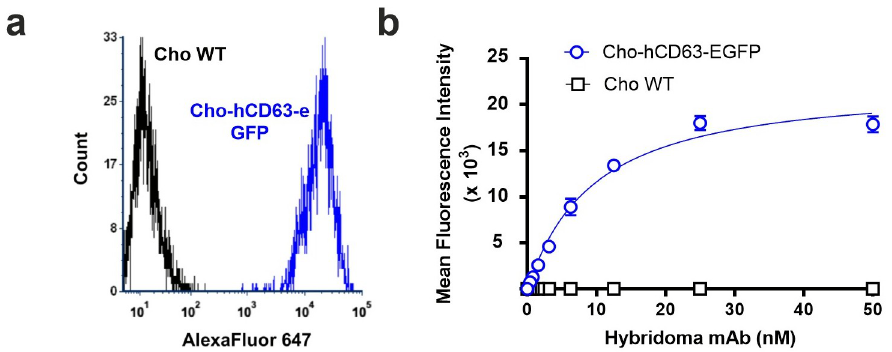
Fig 2. (a) Flow cytometry histogram in far red channel showing staining of Cho-hCD63-eGFP cells, but no Cho WT cells, with 25 nM AF647-modified H5C6 hybridoma-derived mAb. (b) Binding curve derived from flow cytometry data (n =